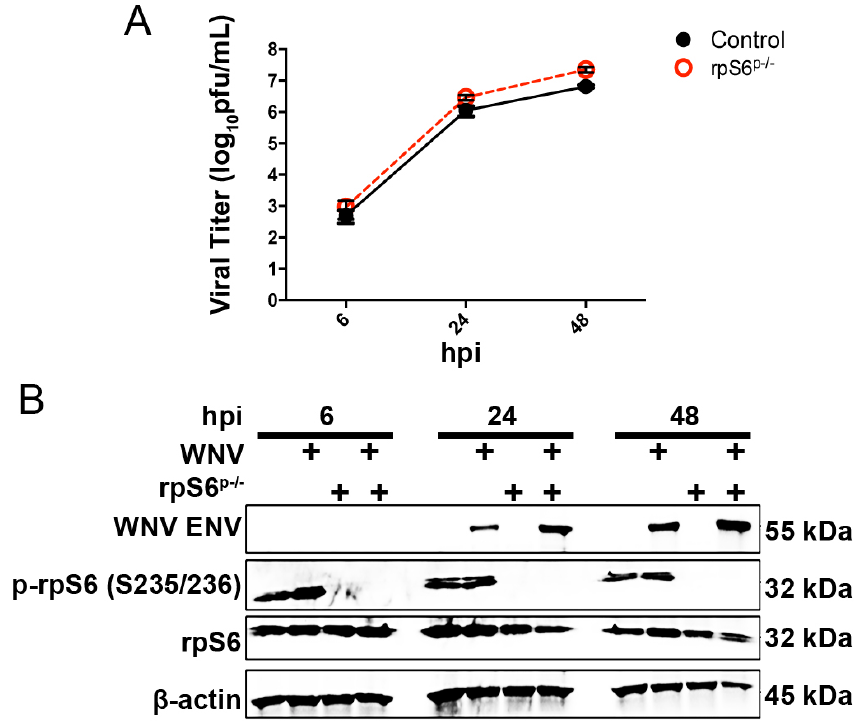
Figure 4. Loss of rpS6 phosphorylation does not impact WNV growth or protein expression. ( A ) Single ‐ step growth curve of WNV (MOI = 3) in rpS6 p − / − and wild ‐ type control MEFs as determined by standard plaque assay of the cell supernatant; ( B ) expression of the WNV envelope (WNV ENV), phospho ‐ rpS6 (serine 235/236) and total rpS6 as determined by Western blot analysis of mock ‐ and WNV ‐ infected (MOI = 3) rpS6 p − / − and wild ‐ type cells. Total cellular protein lysates were collected at the indicated hpi and probed using antibodies against the indicated targets. β‐ actin was